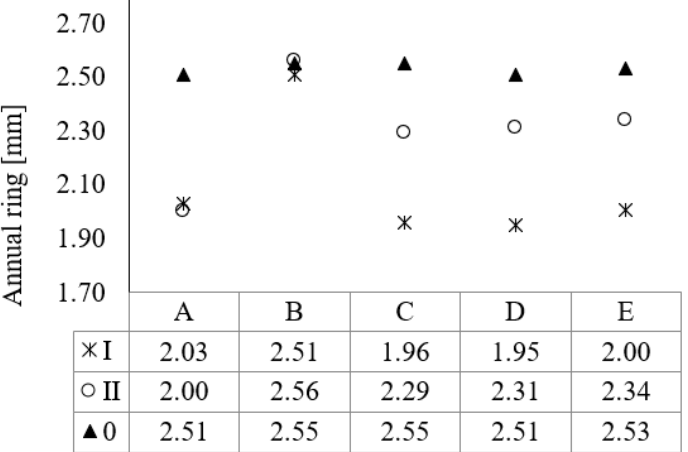
Figure 5. Increment variability on the width of annual ring depending on the pruning variant